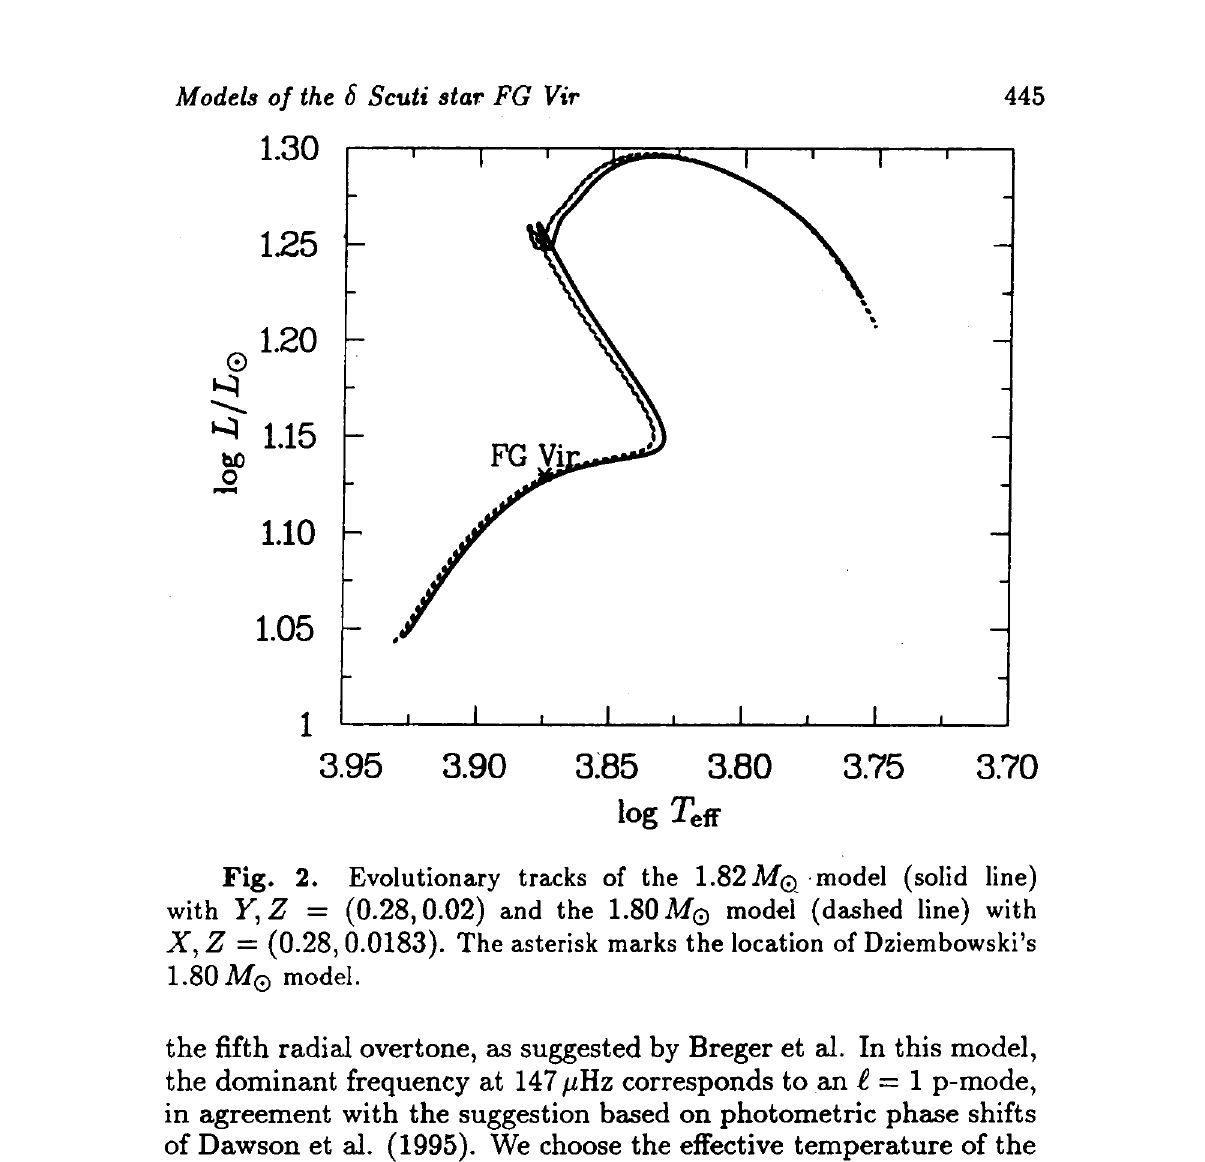
Fig. 2. Evolutionary tracks of the 1.82 MQ model (solid line) with Y,Z = (0.28,0.02) and the 1.80 M© model (dashed line) with Χ, Ζ = (0.28, 0.0183). The asterisk marks the location of Dziembowski's 1.80 M©